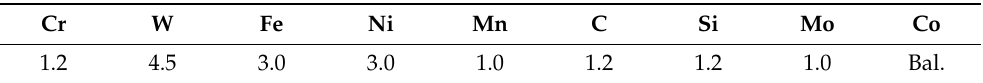
Figure 1. Macroscopic morphology of the Co-based alloy coating fabricated via the laser cladding process. Table 1. Chemical composition of the Co-based alloy powder (wt.%).